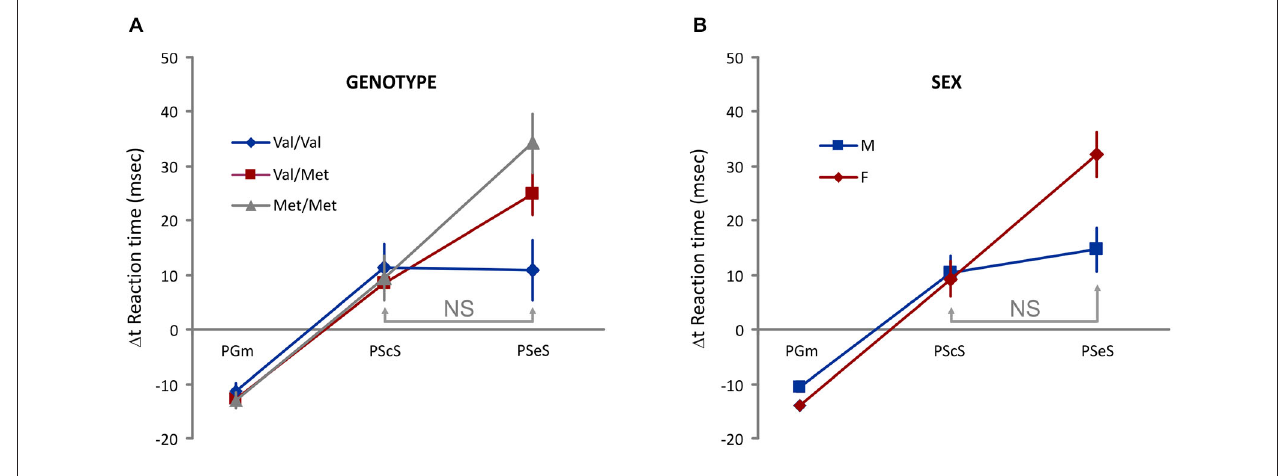
∆ t * Genotype: Val/Val: PScS vs. PSeS p = 1; PScS vs. PGm and PSeS vs. PGm ps < 0.05; Val/Met: PScS vs. PSeS; PScS vs. PGm and PSeS vs. PGm ps < 0.05; Met/Met: PScS vs. PSeS; PScS vs. PGm and PSeS vs. PGm ps < 0.005. Interaction Type of ∆ t * Sex: Males: PScS vs. PSeS p = 1; PScS vs. PGm and PSeS vs. PGm ps < 0.00005; Female: PScS vs. PSeS; PScS vs. PGm and PSeS vs. PGm ps <